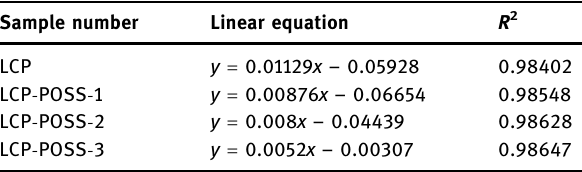
Table 5: Result of dynamic behavior of cis – trans